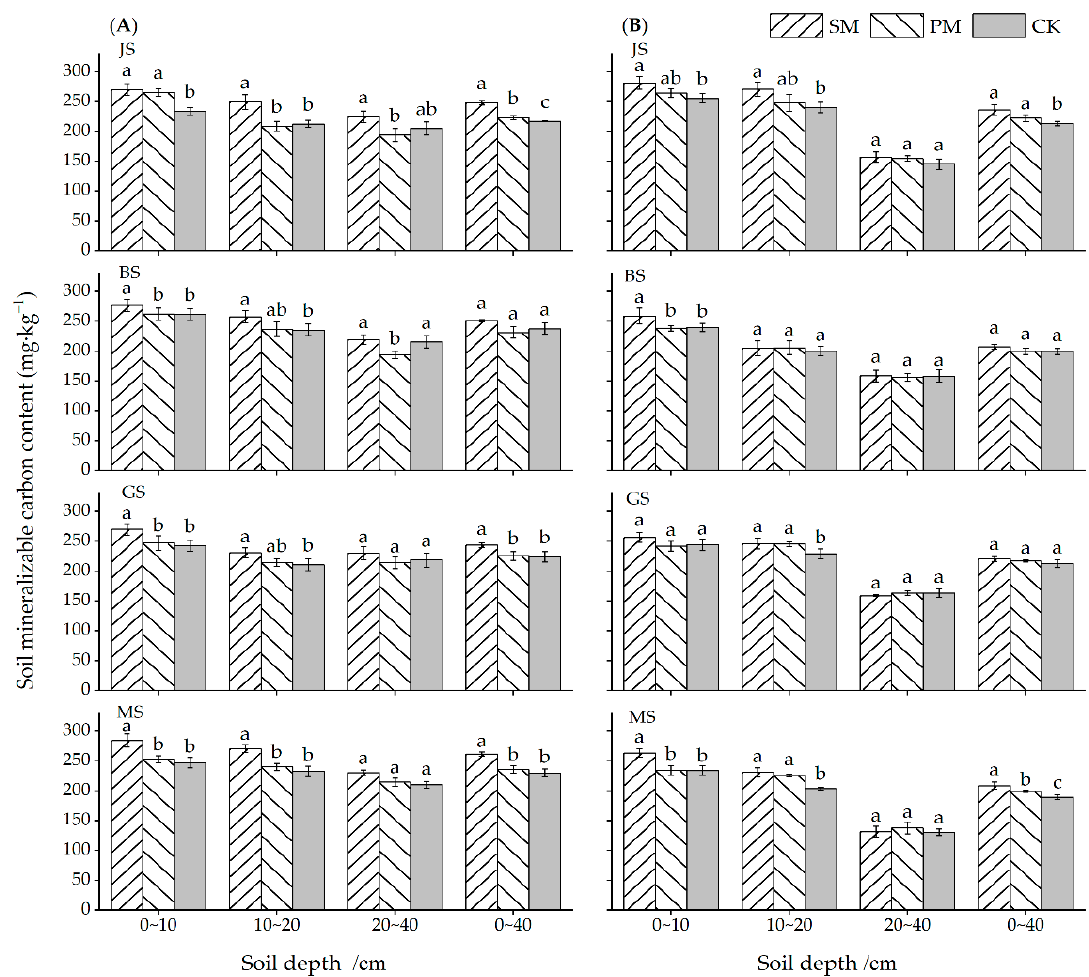
Figure 4. Soil mineralizable carbon contents (PCM) in different growing periods of winter wheat. ( A ) 2019–2020; ( B ) 2020–2021. Lowercase letters denote significance at 5% significance level among